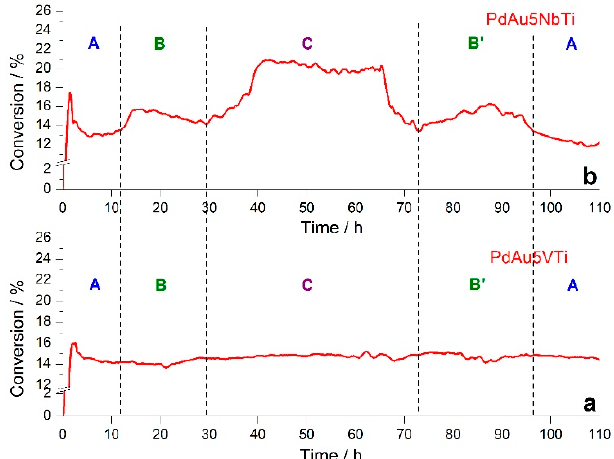
Figure 1. Toluene conversion rate versus time in the ageing of ( a ) PdAu5VTi and ( b ) PdAu5NbTi catalysts.